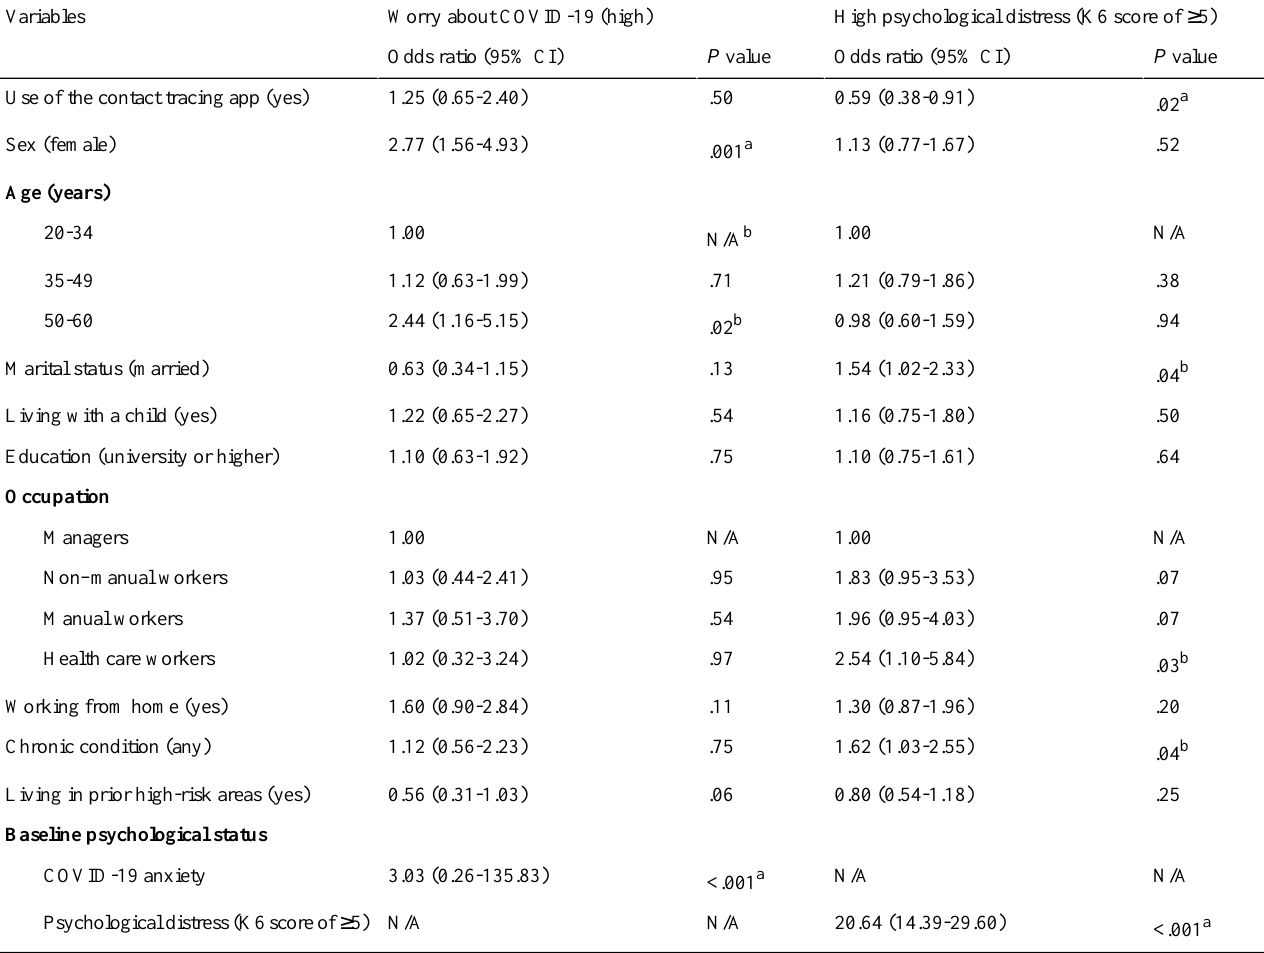
Table 2. The association between use of the COVID-19 contact tracing app and worry about COVID-19 and high psychological distress at follow-up, adjusting for covariates at